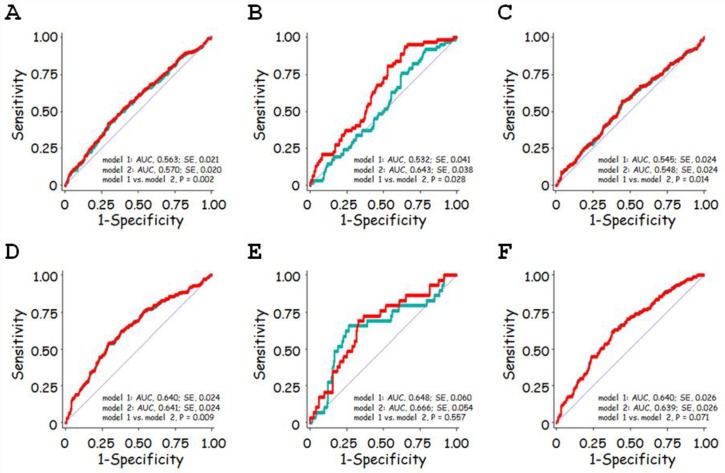
Receiver operating characteristic (ROC) analysis for the prediction of left ventricular hypertrophy (LVH) and low left ventricular ejection fraction (low LVEF).A, B, C. ROC curve for the prediction of LVH. D, E, F. ROC curve for the prediction of low LVEF. Green lines show the ROC curve to predict LVH (A, B, C) and low LVEF (D, E, F) for the combination of age, sex, and eGFR, designated model 1. Red lines show the ROC curve to predict LVH (A, B, C) and low LVEF (D, E, F) for model 1 plus FGF23, designated model 2. For the prediction of LVH, the area under the ROC curve was significantly greater in model 2 than in model 1 for patients with CKD stage G1-G4 (A), G1/G2 (B), and G3-G4 (C). For the prediction of low LVEF, the area under the ROC curve was significantly greater in model 2 than in model 1 for patients with CKD stage G1-G4 (D); however, it did not differ significantly between the two models for patients with CKD stage G1/G2 (E) or G3-G4 (F).